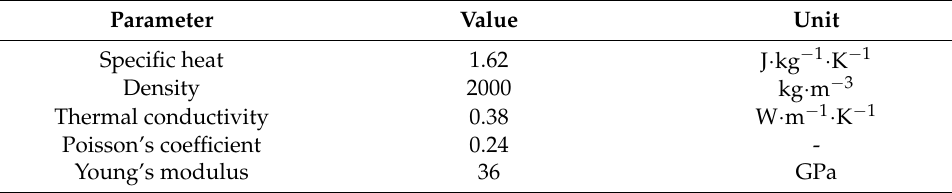
Table 2. Thermal properties of